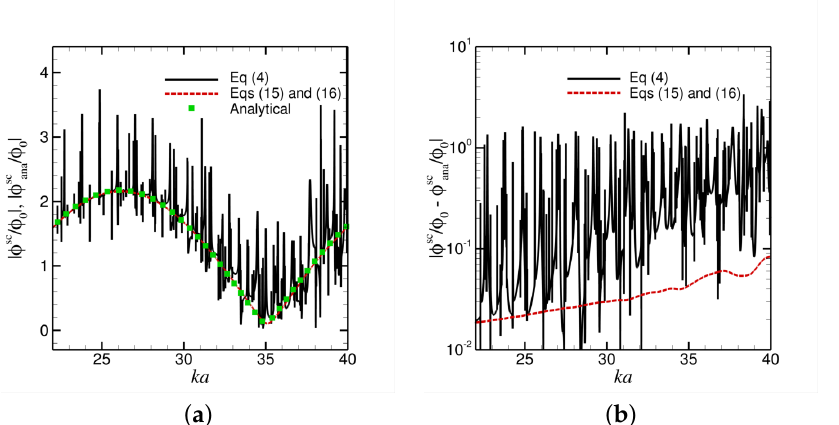
Figure 3. As in Figure 2, the spherical test case for ka = 22 to 40. ( a ) Scaled results of the scattered potential with the non-singular standard boundary element method (in black), the desingularised Burton–Miller framework (red line), and the analytical solution (in green). ( b ) Error between the analytical result and the non-singular standard boundary element method (black line) and the desingularised Burton–Miller framework (red